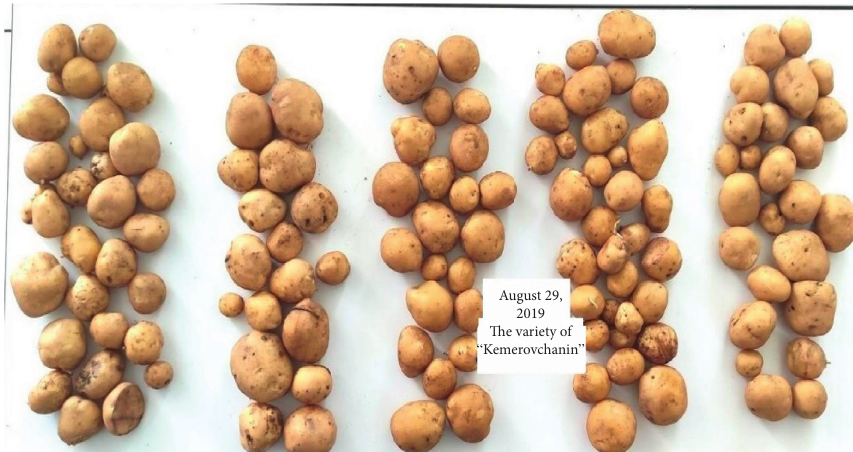
Figure 2: The yield of “Kemerovchanin” potato variety: in the left is control and in the right is Phytop 26.82. Table 4: The effect of bacterial strains on the morphological parameters of the “Kemerovchanin” potato by the counting week. Experience variants Counting week Weight of 1 plant gram The length of the stems (cm)